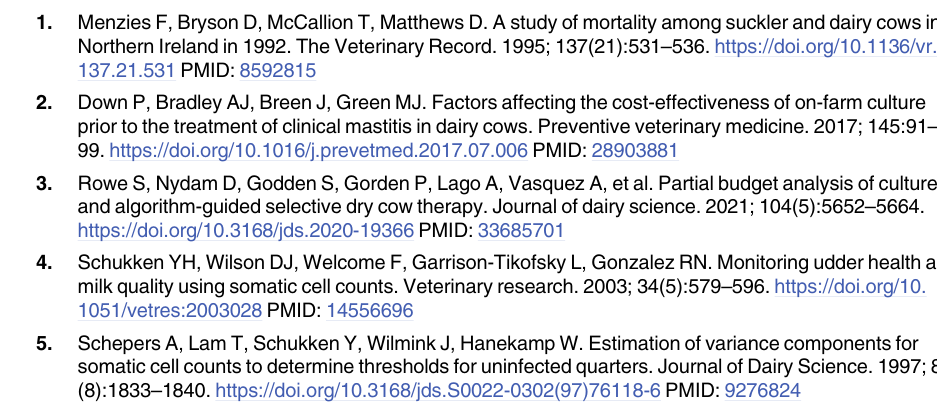
S1 Table. DSCC along SCC classes. Average DSCC per SCC class (horizontal axis: from 50k to > 1000k) overall and per parity or timepoint, in the top section of the table; proportion of records with DSCC > 70% in the bottom section of the table. S2 Table. Estimated fixed and random effects from the DSCC-SCC bivariate model. S1 Fig. 2x2 tables with the distribution of samples along combinations of SCC and DSCC above/below critical